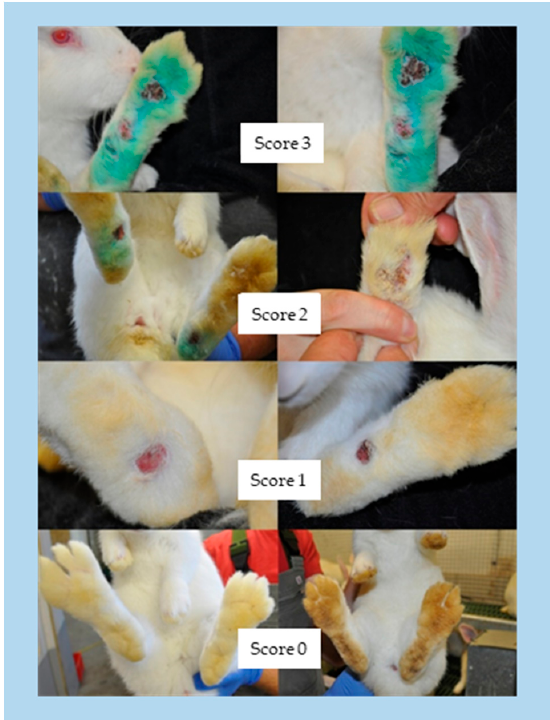
Figure 6. Scheme for assessing injuries to the (hind) limbs with score 0 = not injured to score 3 = severely injured.